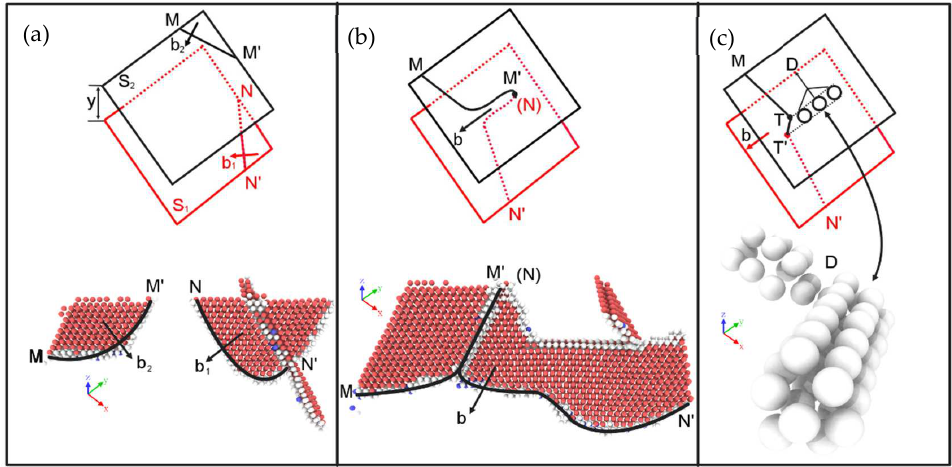
Figure 12. Dislocation jog reaction process. ( a – c ) is a continuous dislocation jog reaction formed by columnar defects.